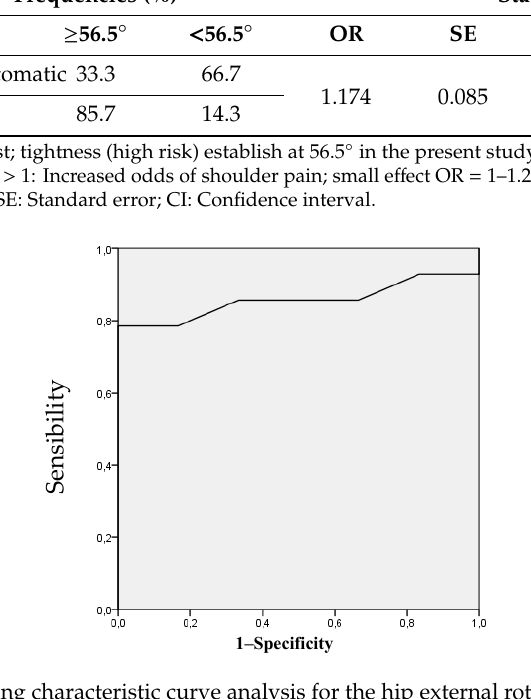
Figure 2. Receiver operating characteristic curve analysis for the hip external rotation ROM as a risk factor for lower back pain. The area under the curve is 0.857 ( p = 0.013); the coordinates represent possible cutoff point in hip external rotation range of movement (the optimal cutoff point was 56.5°).